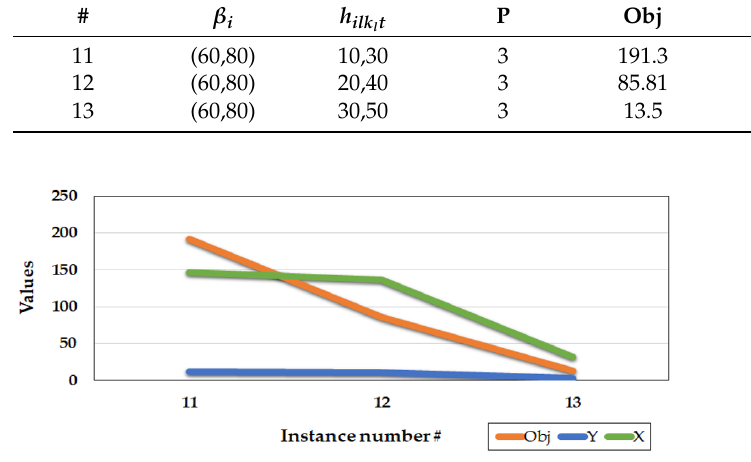
Figure 4. Results of the sensitivity analysis for the module assignment cost.